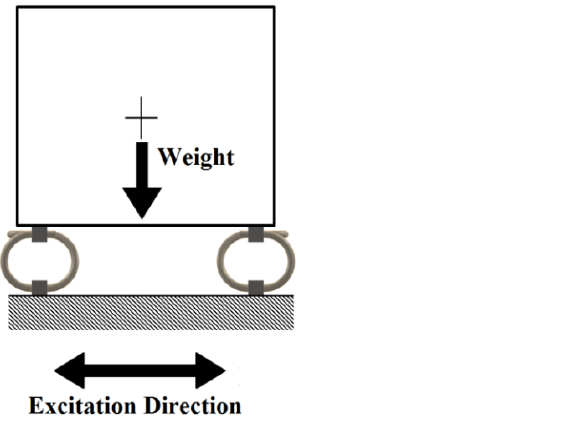
Figure 3. WRI carrying a vertical load and subjected to lateral excitation.